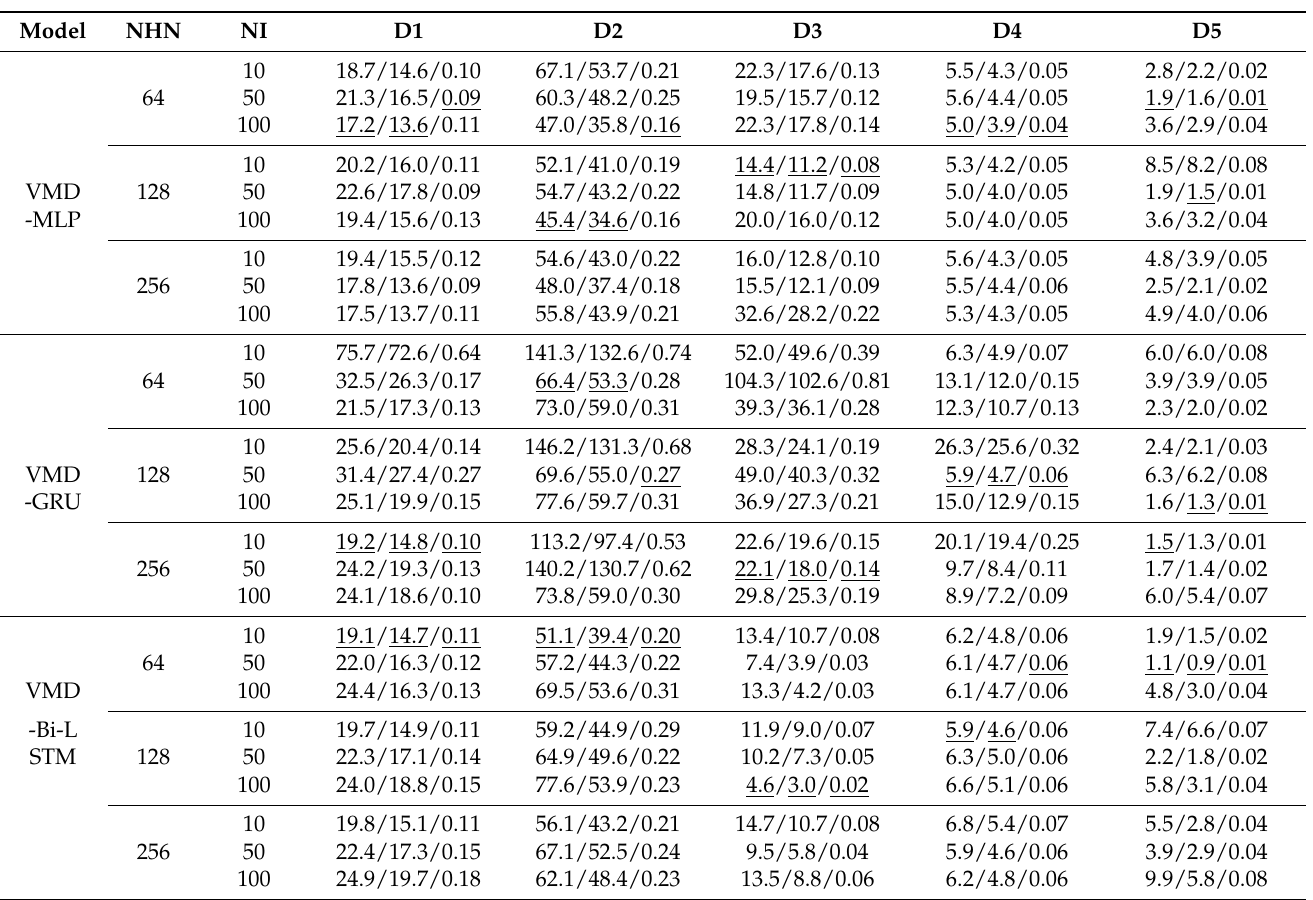
Table 1. Prediction error of 1 h